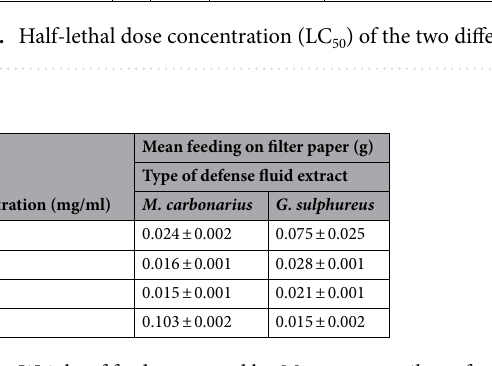
Table 5. Weight of feed consumed by Macrotermes gilvus after mortality-inducing treatment with the two types of extracts.